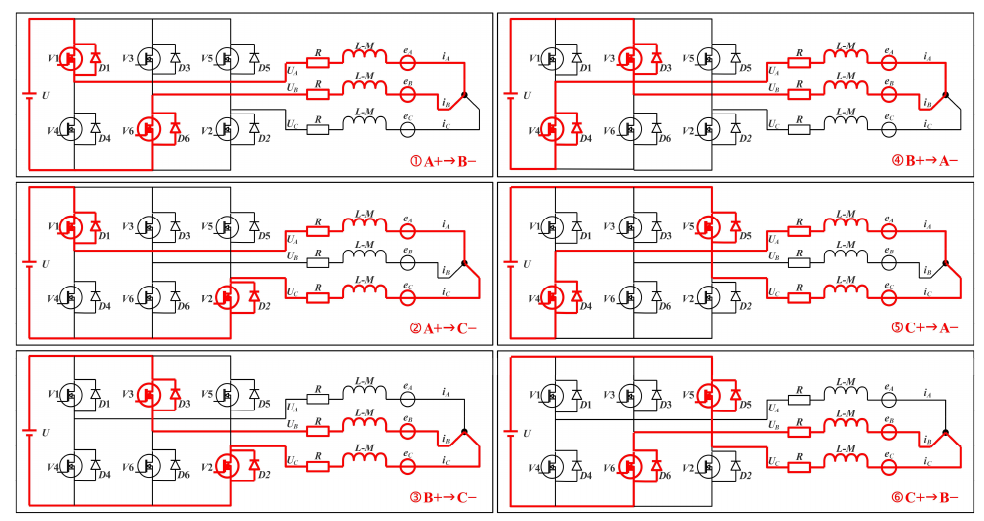
Figure 6. Logical commutation sequence of Mosfet.